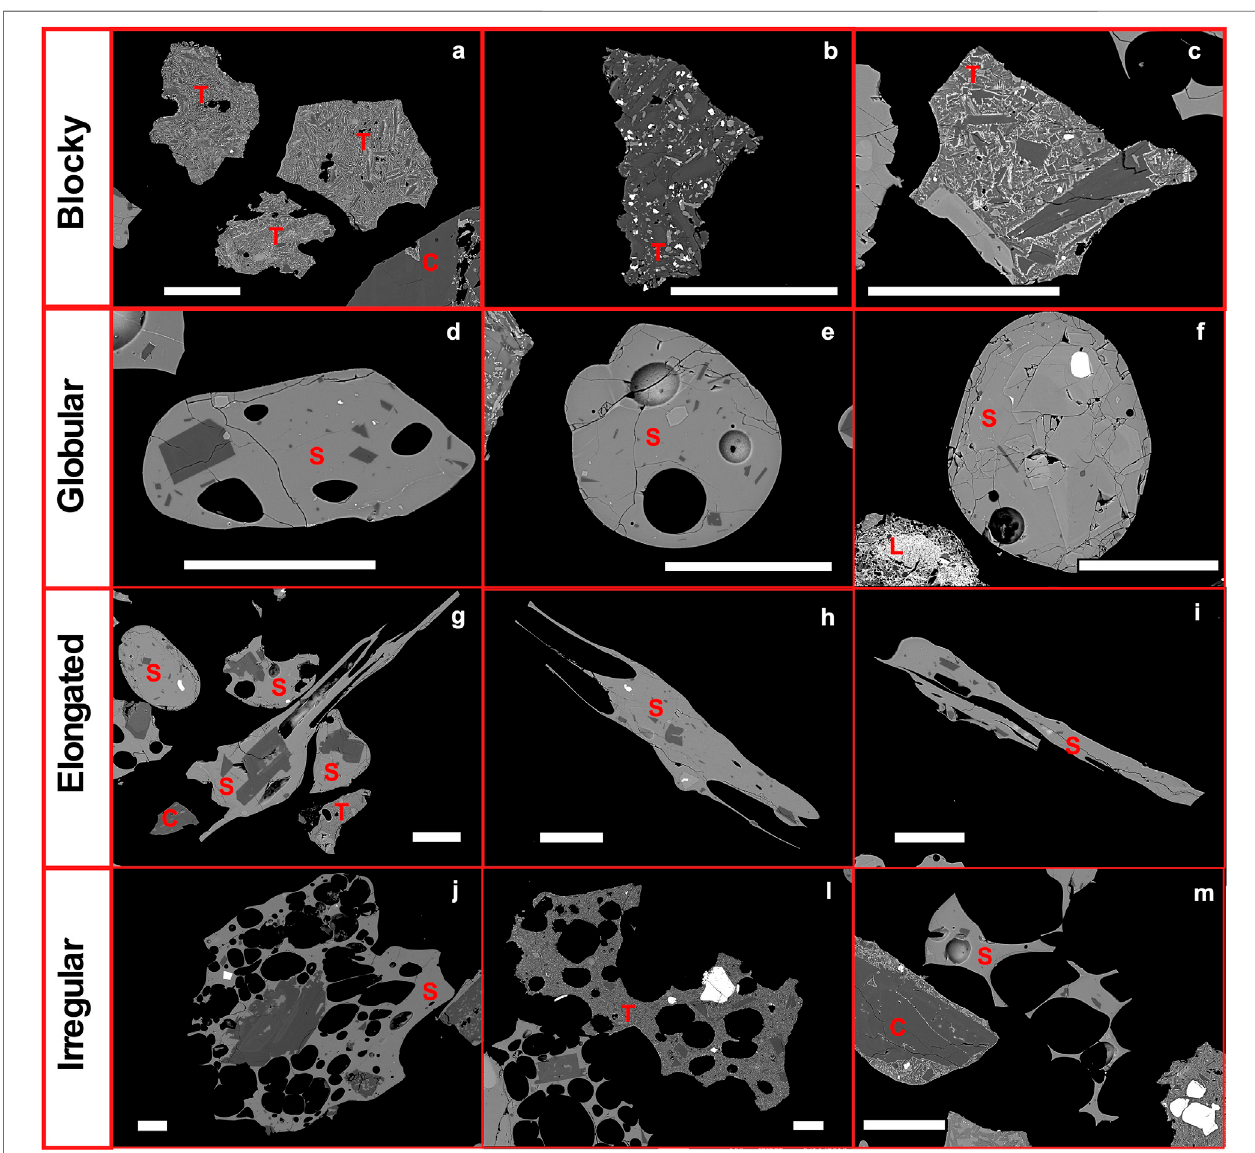
FIGURE 2 | Representative SEM-BSE images of 125 – 180 μ m sideromelane (S), tachylyte (T) crystal (C) and lithic (L) particles, grouped by shape categories. Images are grouped based on the shape category of the main particle in the picture. Scale bars are 100 µm long.